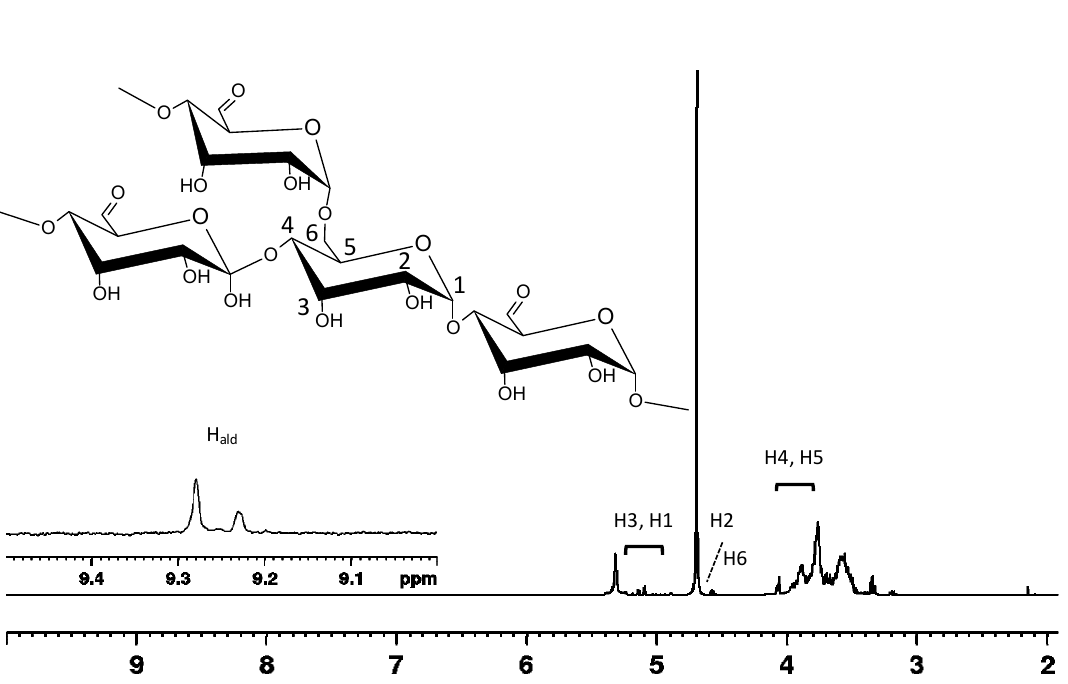
Figure 1. 1 H NMR spectrum of partially oxidized pea starch (sample C), recorded at 298 K, in D 2 O (for simplicity, only the numbering scheme of the amylopectin derivative is illustrated; the assignment refers to partially oxidized starch).